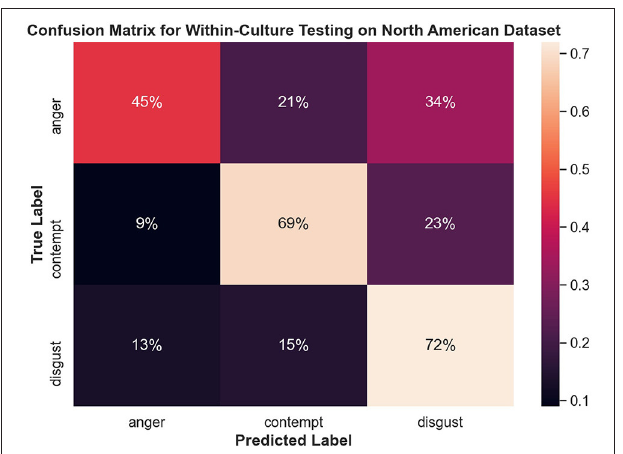
FIGURE 11 | Confusion matrix illustrating the results of the within-culture experiment on the Filipino data